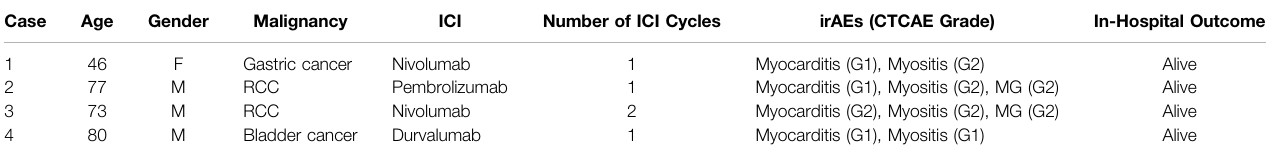
TABLE 1 | Demographics and patient information of our institutional cases.